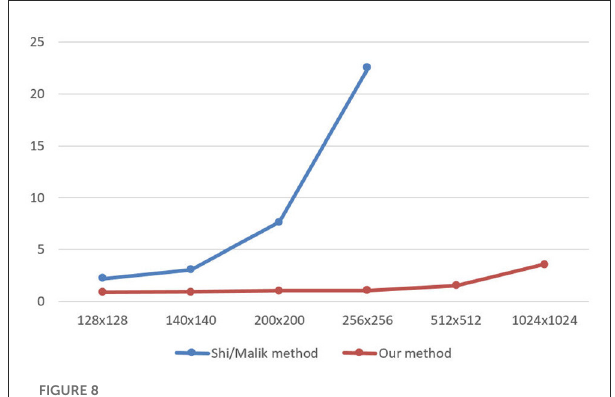
FIGURE8 The speed time to calculate image segmentations between Shi/Malik algorithm and Our algorithm.